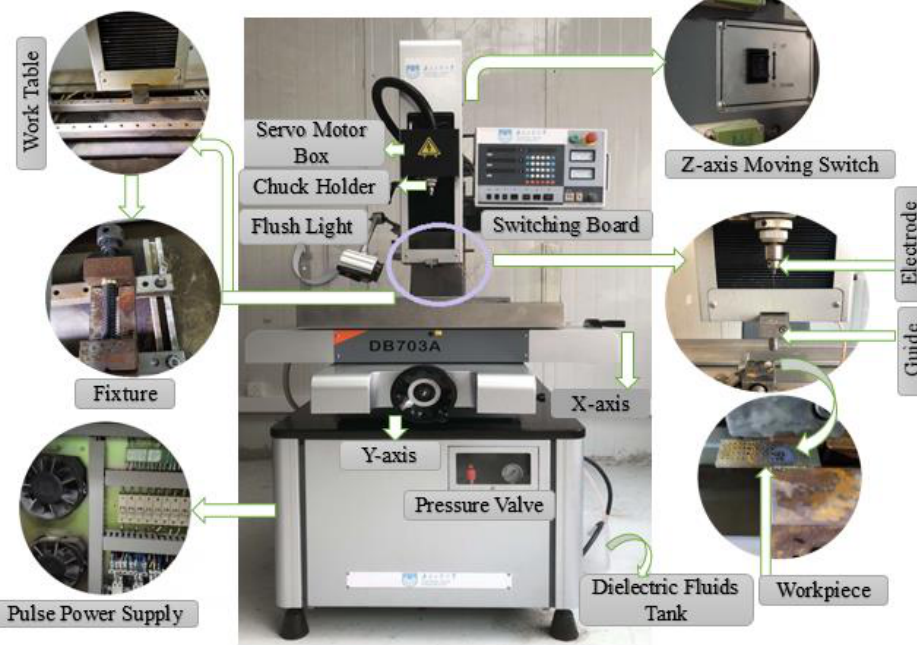
Figure 2. Photograph of the electrochemical discharge machining (ECDM) machine tool.